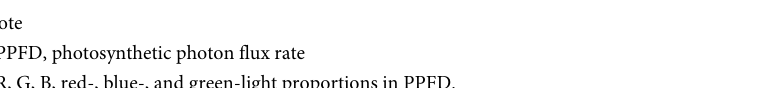
where DQI is the assessed seedling quality index; B are biomass in parts of shoot and root, respectively; H and D are seedling shoot height and